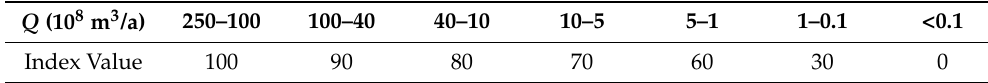
Table 5. Runoff in Cross Section ( Q ) Scoring Criterion.